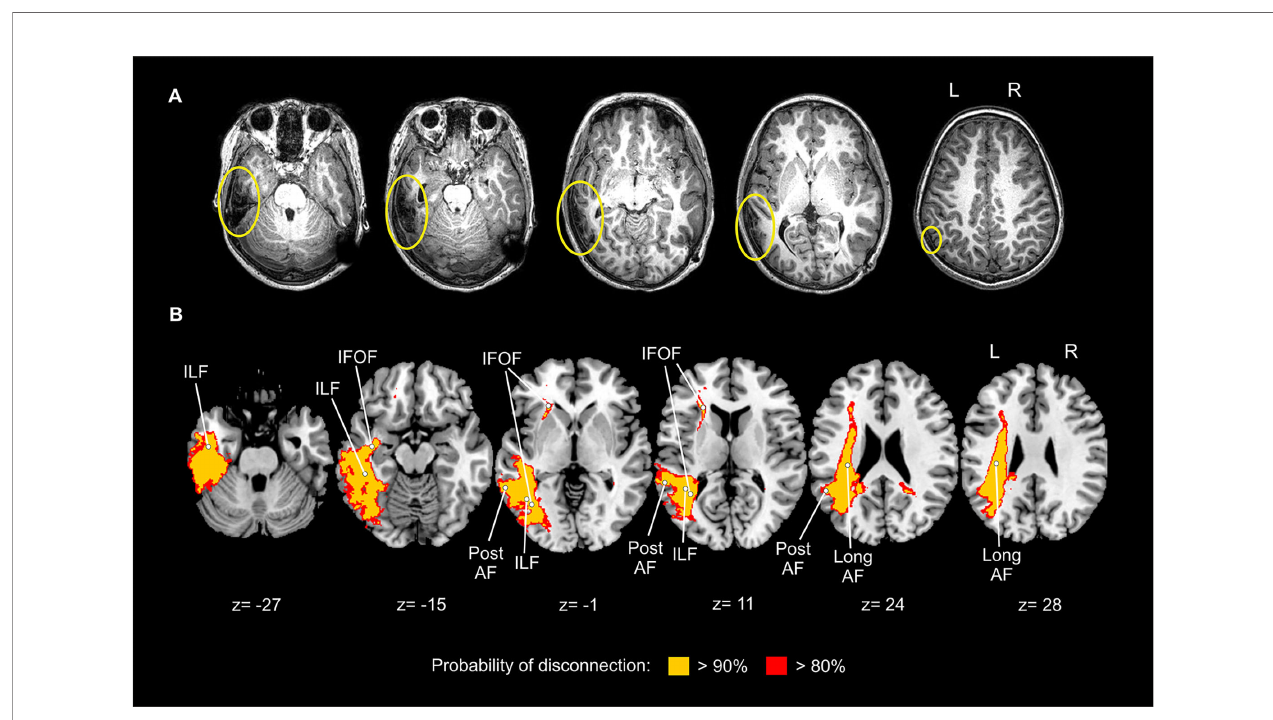
FIGURE 4 | Depiction of the brain lesion and disconnection pattern. (A) MRI T 1 -weighted image showing the lesion in the left temporo-parietal cortex in native space. Yellow circles indicate brain lesions. (B) Probability of disconnection of brain areas not directly affected by the lesion as revealed by the Disconnectome map software. Two different probability thresholds are presented. The disconnection map is overimposed on a brain template in standard MNI space. L, left; R, right; ILF, inferior longitudinal fasciculus; IFOF, inferior fronto-occipital fasciculus; post AF, arcuate fasciculus posterior segment; long AF, arcuate fasciculus long